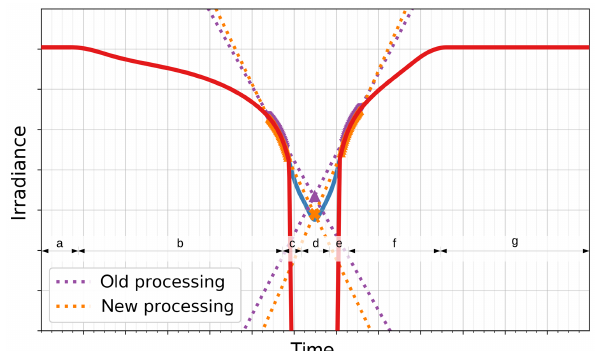
Figure A2. Like Fig. A1 but with a measured irradiance time se- ries (red line) of a shadowband sweep. The blue line indicates the unknown amount of blocked diffuse irradiance, which has to be es- timated by the processing algorithm. The dotted lines indicate the extrapolation lines of the old (purple) and new (orange) processing algorithms to estimate the blocked diffuse